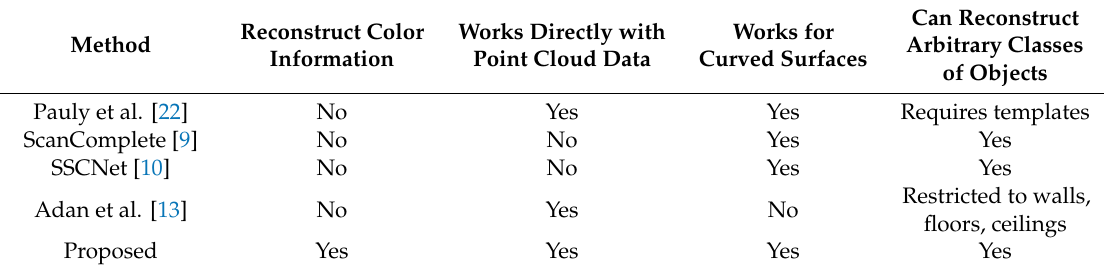
Table 9. Qualitative comparison of the proposed scene completion method compared to other works in the